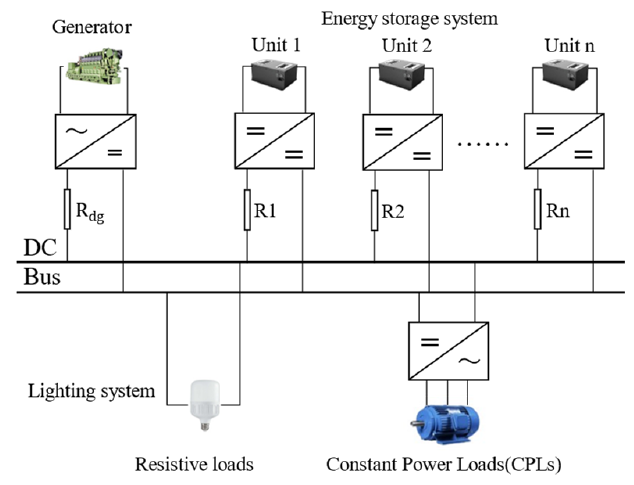
Figure 3. Physical layer structure diagram of ship DC microgrid.